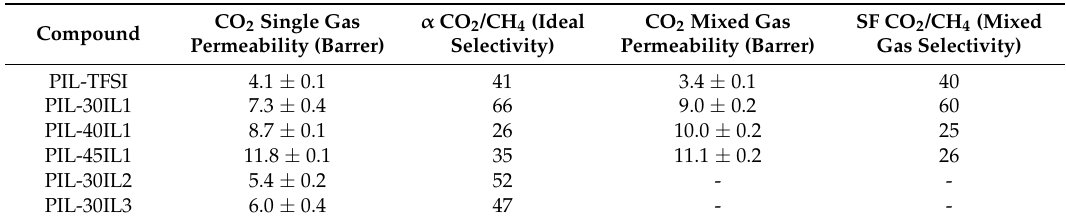
Table 3. Separation performance of the prepared PIL-TFSI and PIL-IL membranes at room